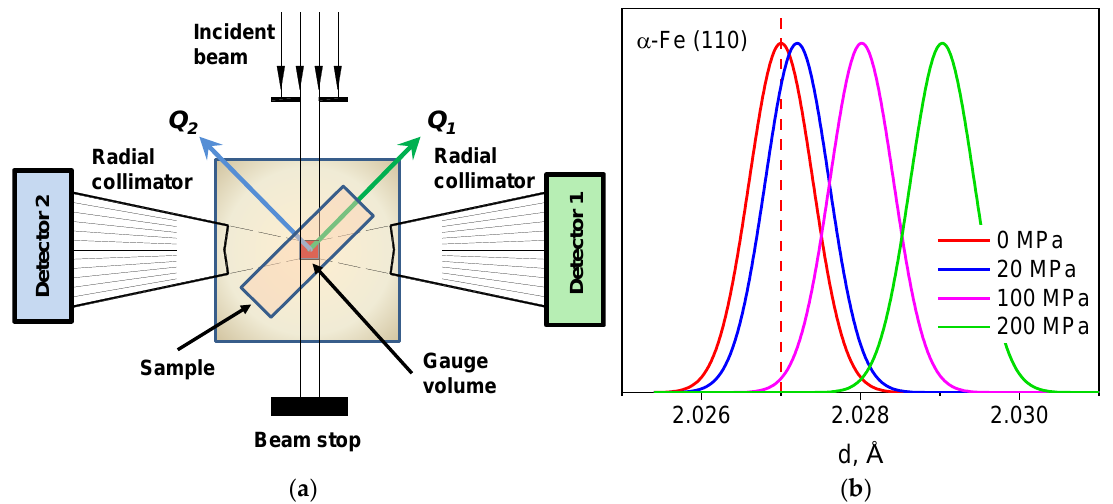
Figure 1. ( a ) Experimental layout for residual stress scanning in a bulk object. Incident and scattered neutron beams are restricted by a diaphragm and radial collimators shaping a gauge volume within the specimen; ( b ) Visualization of diffraction peak (110) shift at stress values of 20, 100, and 200 MPa observed at the diffractometer with a resolution level of R = Δ d / d ≈ 0.001 (ferritic steel, E ≈ 200 GPa).